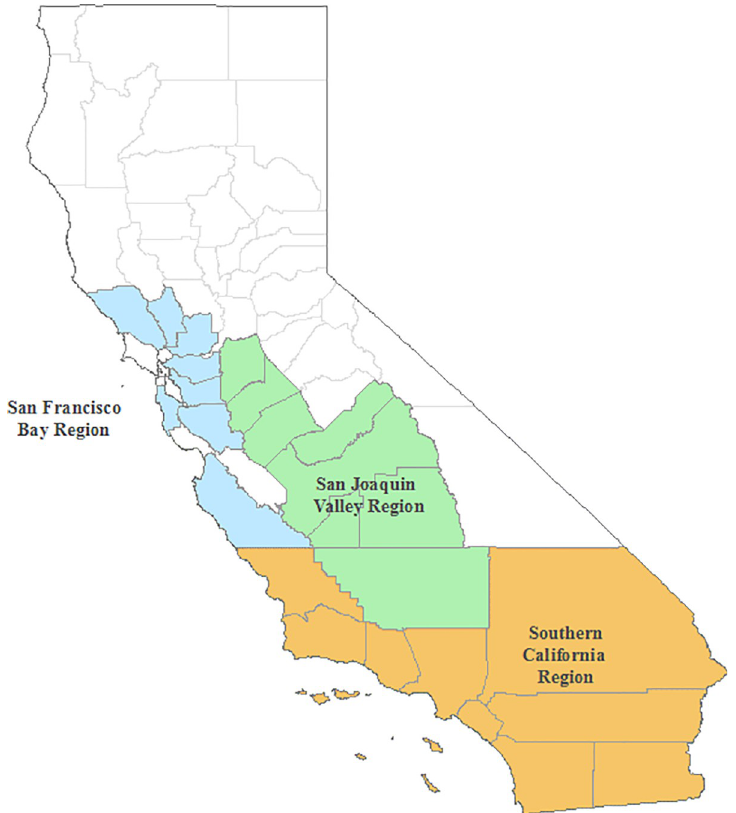
Fig 1. Map of regions and associated counties included in the study.